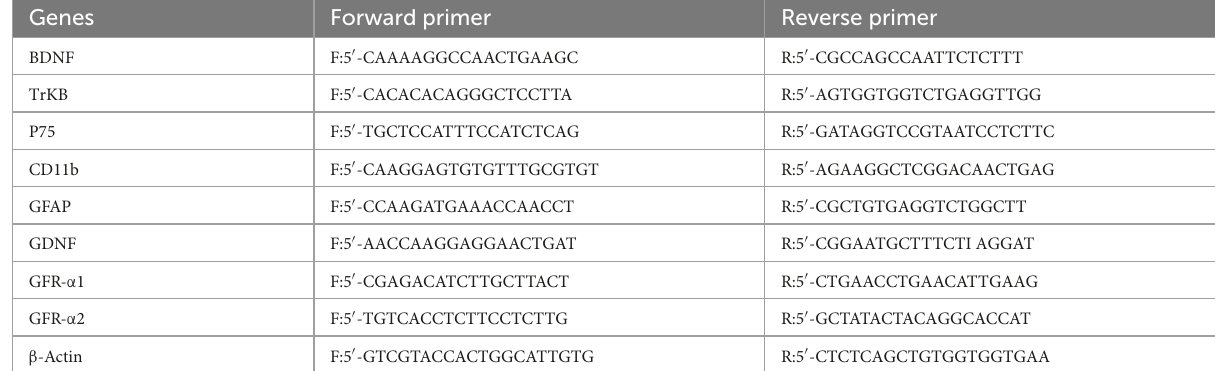
TABLE 2 The primer sequences of target genes.